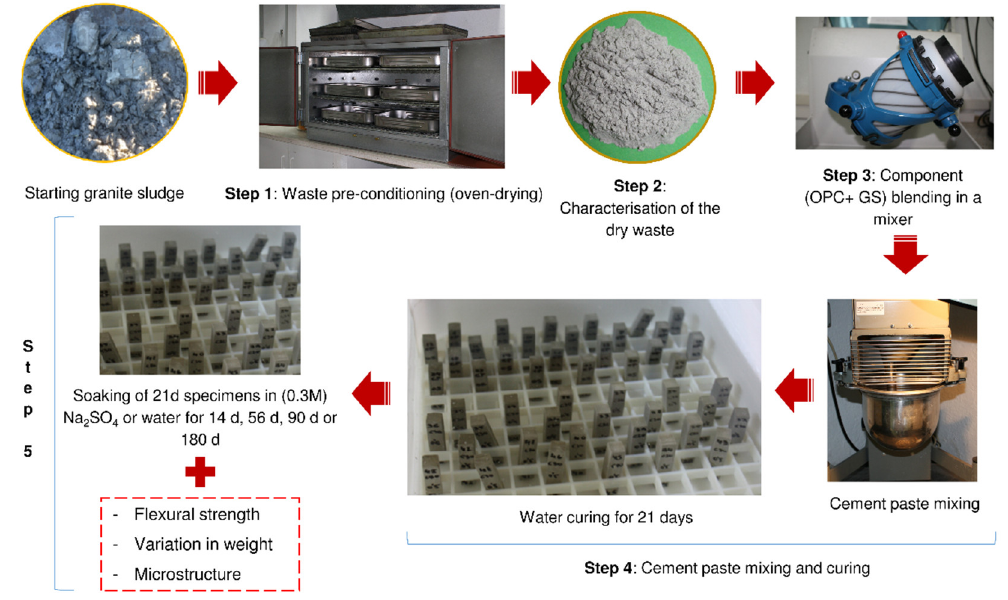
Figure 2. Steps comprising the research conducted.